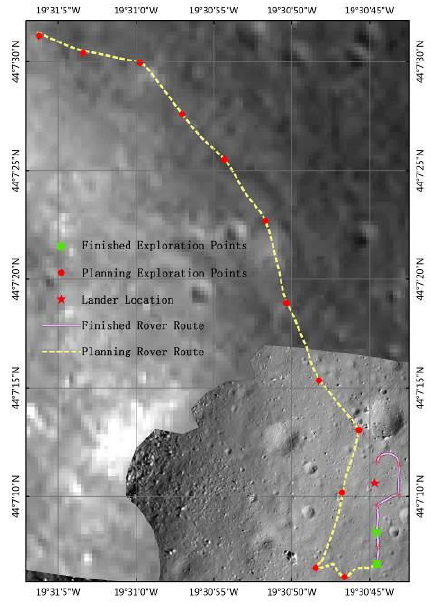
Figure 4. The preliminary scientific exploration planning of the the Yutu